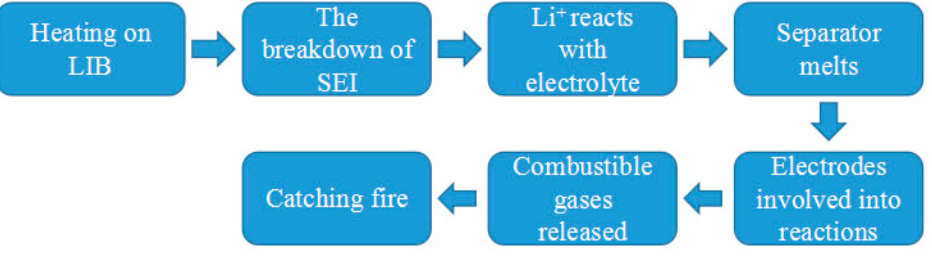
Figure 13. The schematic of s battery catching fire.